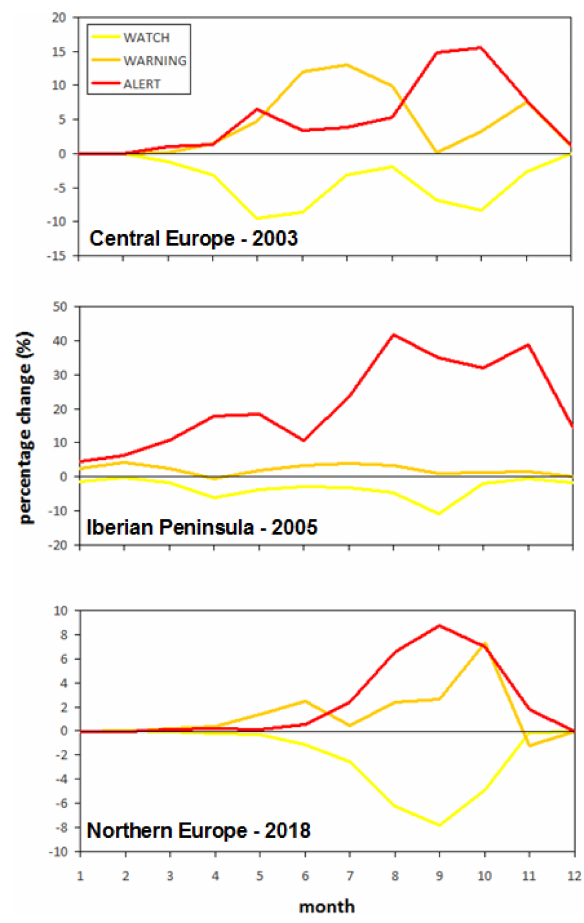
Figure 10. Percentage differences between the CDI-v1 and CDI-v2 fraction of area in the WATCH (yellow line), WARNING (orange line), and ALERT (red line) stages for the same three main droughts depicted in Figs. 7–9. Negative (positive) values indicate a reduction (increase) in CDI-v2 compared to